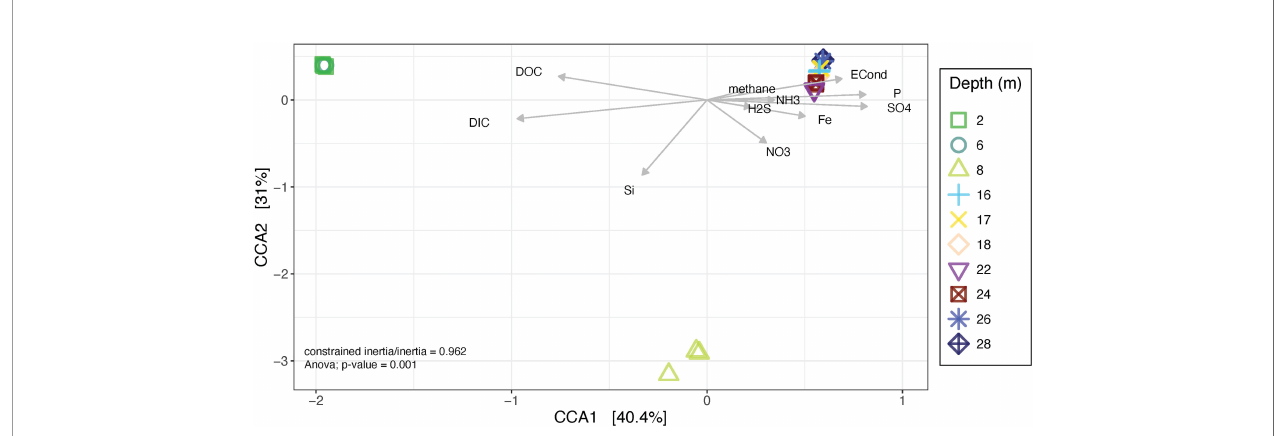
FIGURE 8 | Canonical Correspondence Analysis (CCA) plot of microbial community composition with environmental data plotted as explanatory variables. Each point represents a replicate at the depth indicated in the legend. Arrows show quantitative explanatory variables with the arrowhead indicating the direction of